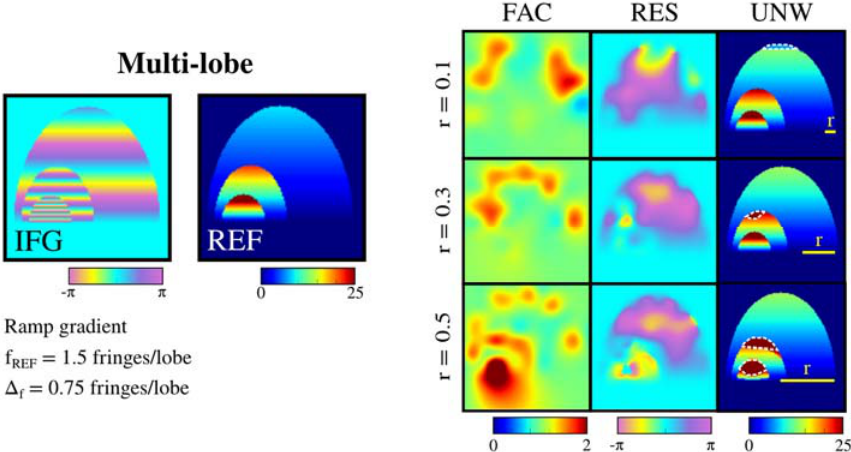
Figure 6. Sensitivity analysis with simulated data, impact of the demodulation patch radius r on the algorithm performance (multi-lobe scenario). IFG: To-be-demodulated interferogram (wrapped); REF: reference interferogram (unwrapped); FAC: demodulation factor; RES: demodulation residual (unwrapped); UNW: demodulated interferogram. FAC, RES, and UNW are obtained for three different r values. The phase errors in UNW are highlighted with white dashed